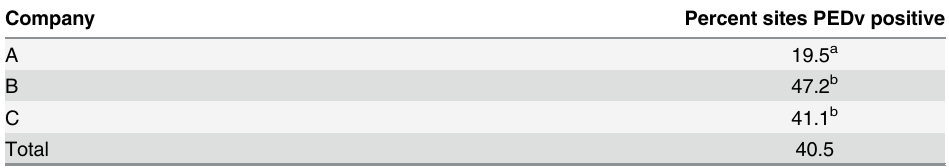
Table 1. Porcine epidemic diarrhea virus (PEDv) site-level incidence during a Spring 2013 outbreak in 4 contiguous U.S. States, by Swine Company.